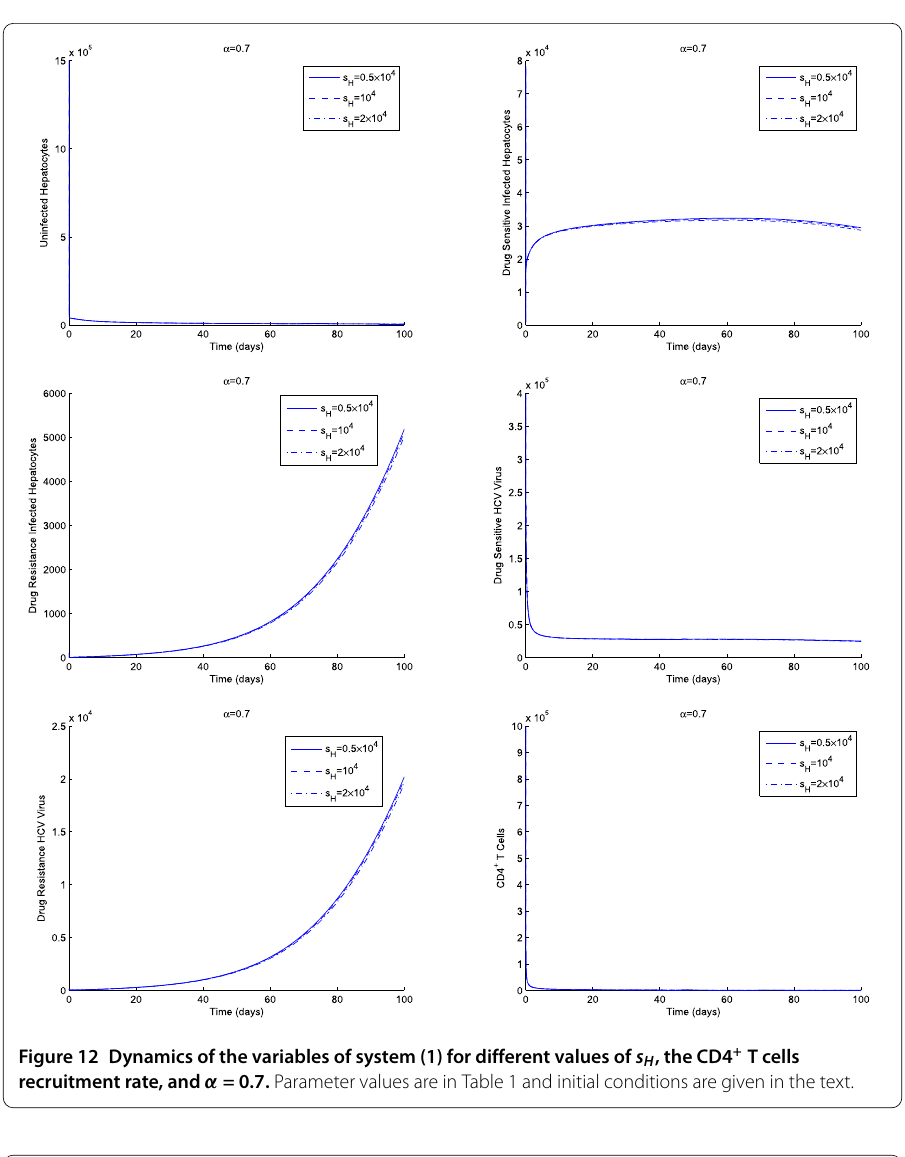
Figure 13 Variation of the value of the reproduction number R 0 as a function of the V H , the HIV viral load and β s , the drug-sensitive transmission rate, for α = 1.0.